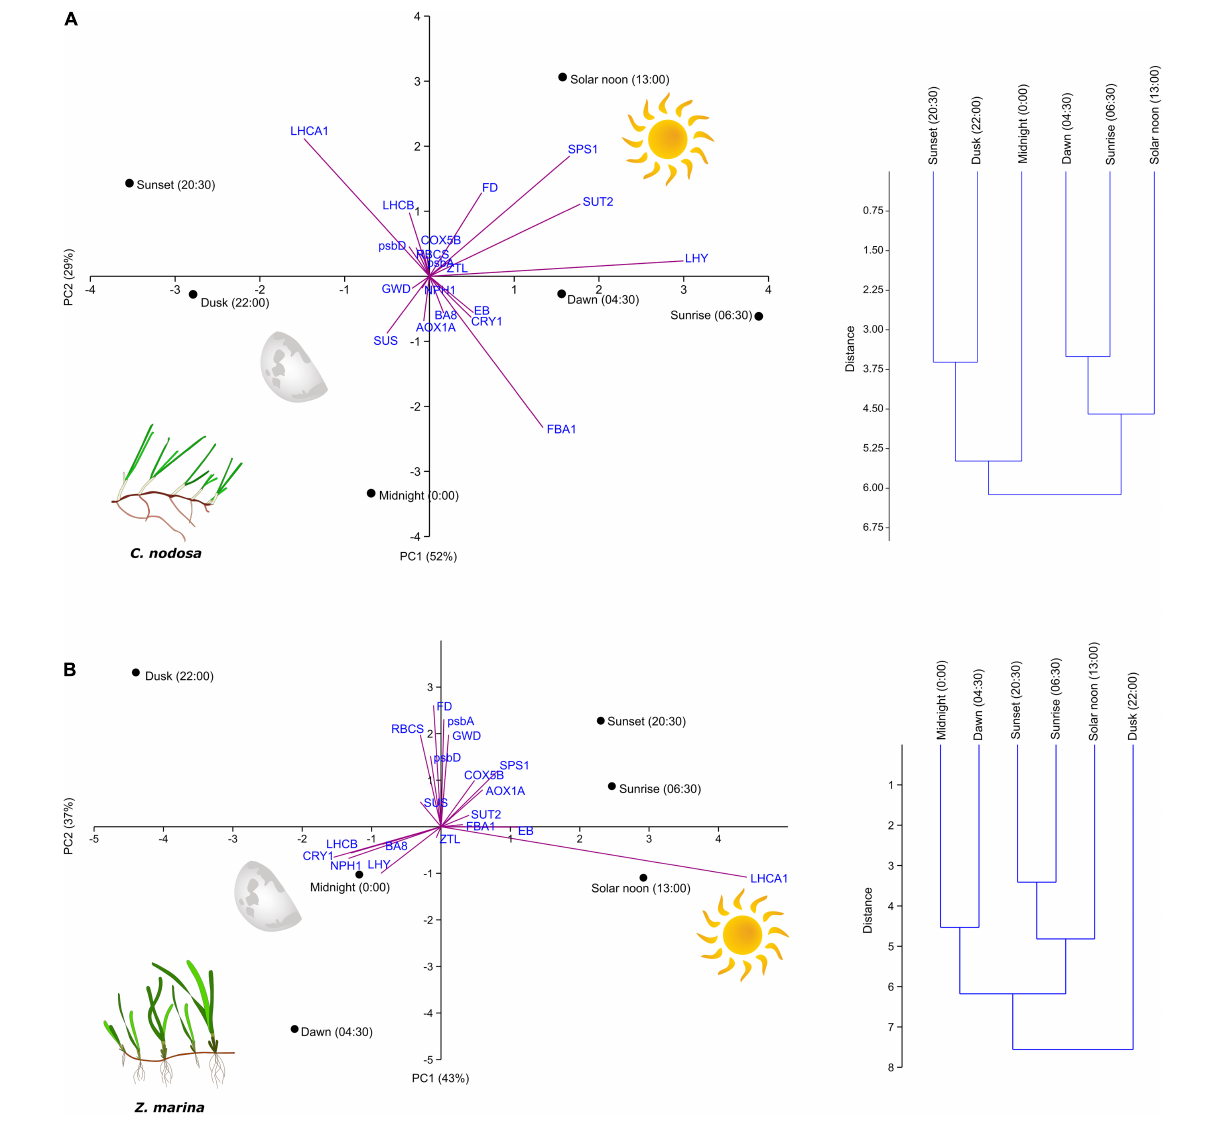
Frontiers in Ecology and Evolution |